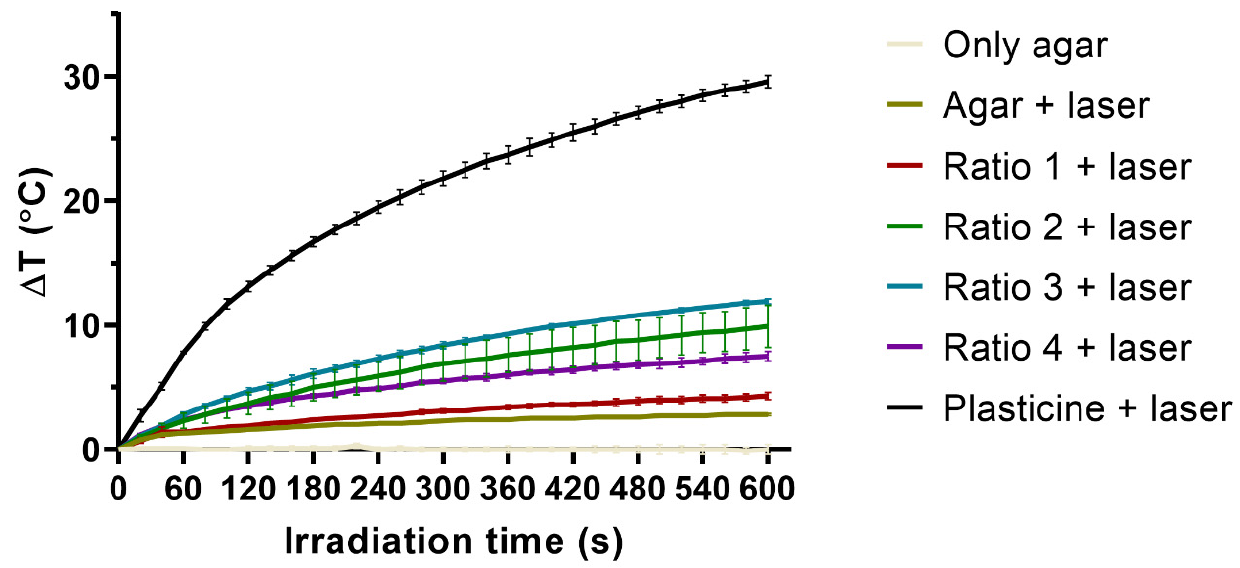
Figure 7. Evolution of the phantoms’ temperature as function of the irradiation time with a NIR laser. The Au concentration in all 4 Ratios was the same as for the in vitro studies. The results represent the mean value ± SD, n = 3.